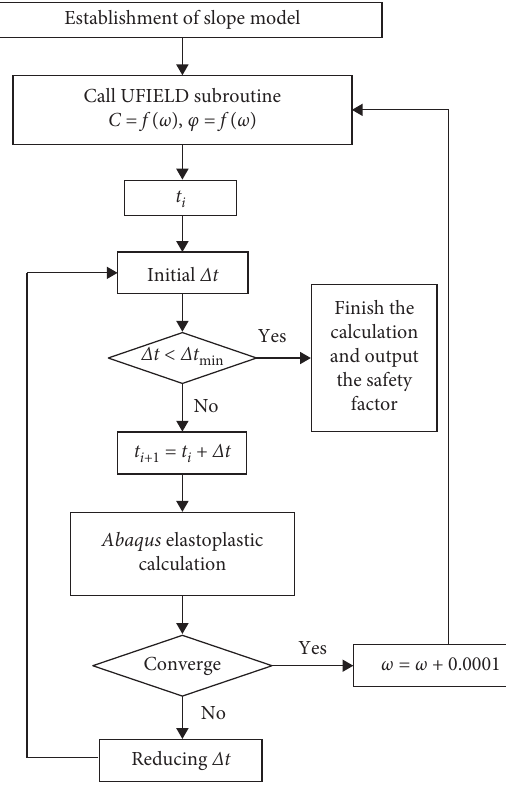
Figure 1: Flowchart of the nonproportional correlative reduction method used to determine the slope’s double safety factors.